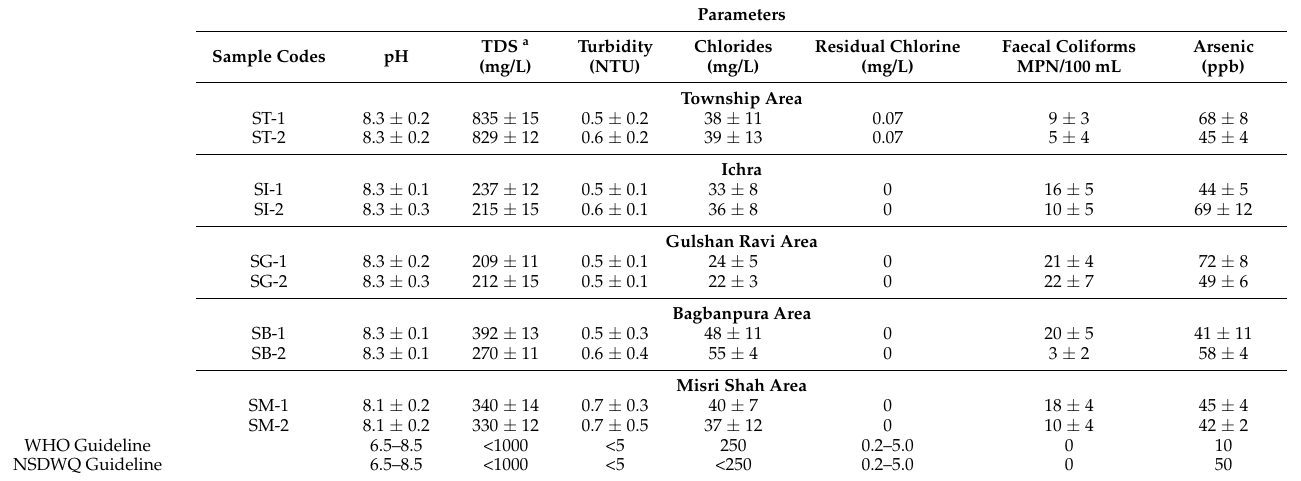
Table 2. Results of analysed parameters at selected locations of Lahore.